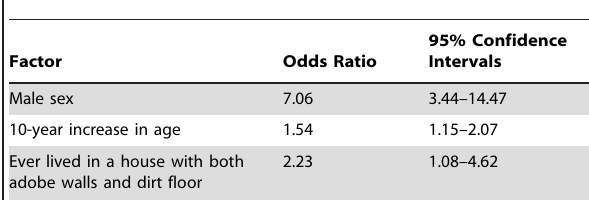
Table 4. Multivariable logistic regression model of factors associated with severity of Chagas cardiomyopathy, defined as Chagas stage C or D (versus Chagas stage A or B).